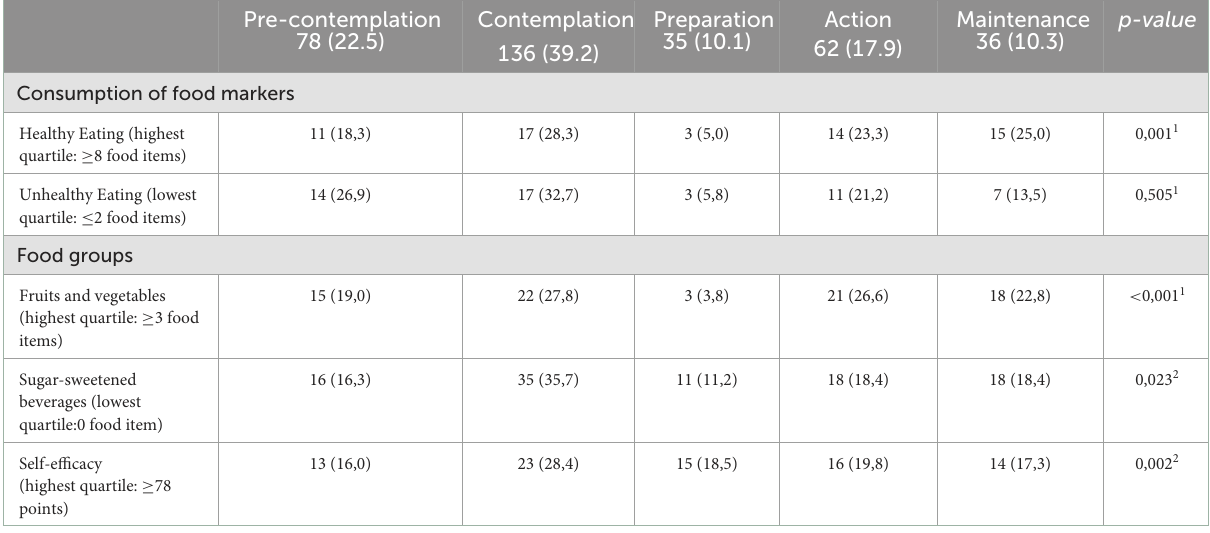
TABLE 1 Distribution of the participants’ consumption of food markers, food groups consumption, and self-efficacy in the adoption of healthy eating practices according to the stages of